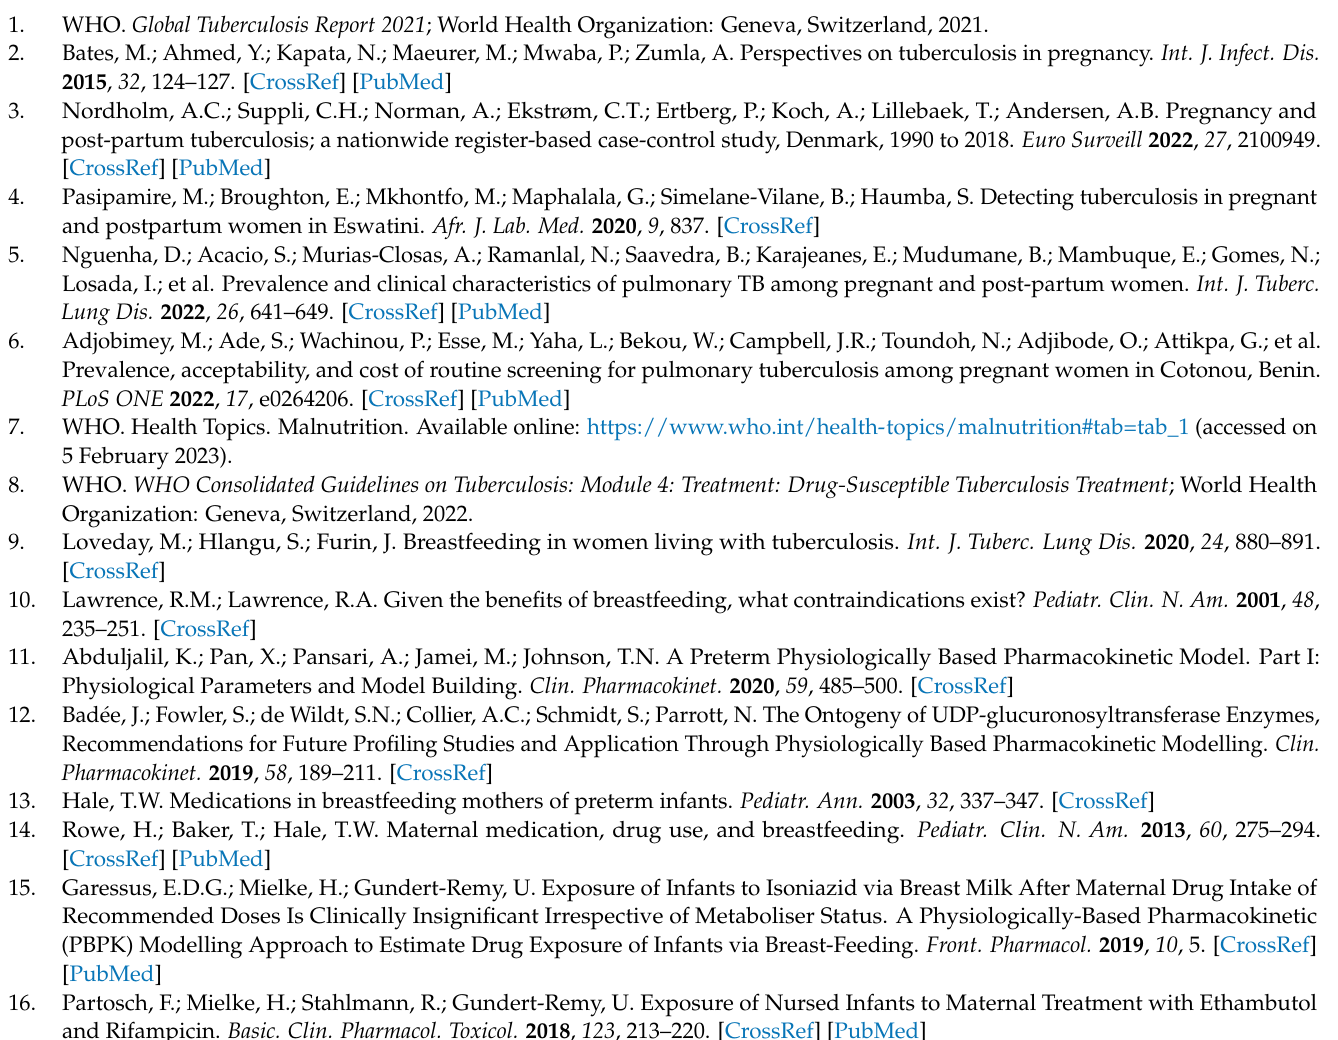
Table S1: Search string for literature collection in PubMed; Table S2: Checklist for quality assessment of clinical pharmacokinetic studies according to Gafar et al. [17]; Table S3: Relevant parameters used in the calculation of milk/plasma ratio for pretomanid. References [18,113–116] are cited in the supplementary